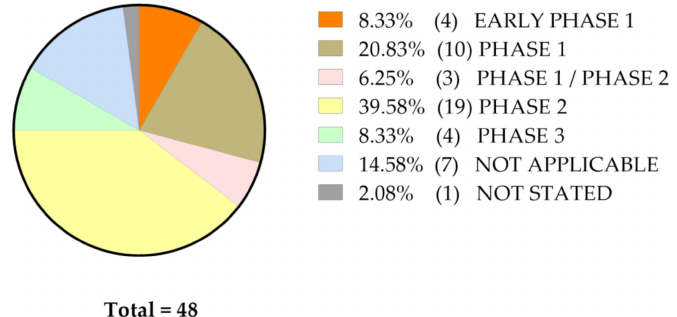
Figure 2. Reported phases of clinical trials involving curcumin, regardless of its formulation and type of malignant